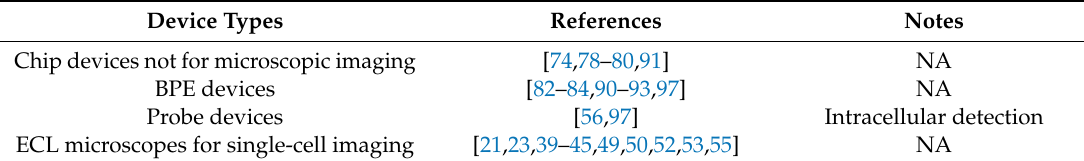
Table 1. Device types for electrochemiluminescence (ECL)-based cell analysis.